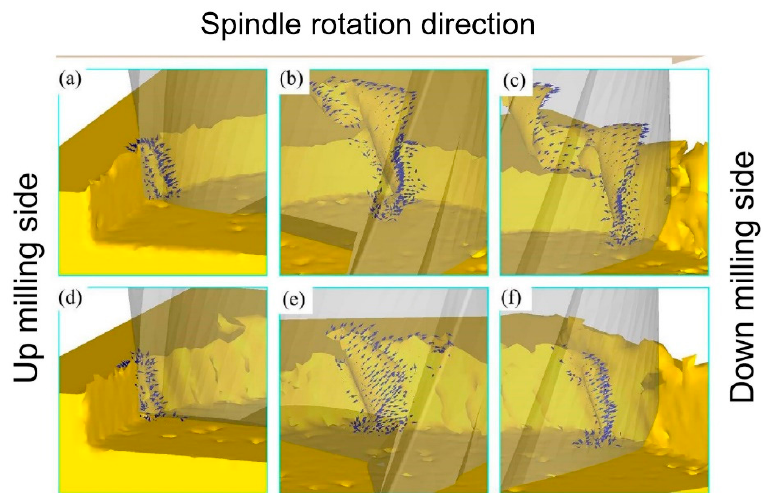
Figure 10. Simulation of burr growth ( a – c ) TMM; ( d – f ) UVAMM. (2) Effect of ultrasonic vibration on burr formation at different V c